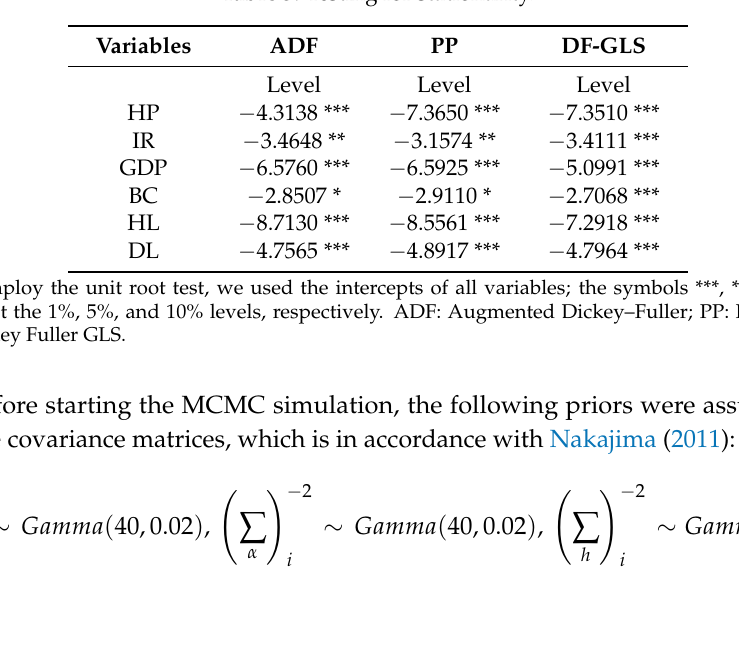
Figure 2. The logarithmic growth of bank credit and housing prices. Table 2. Descriptive statistics. Table 3. Testing for